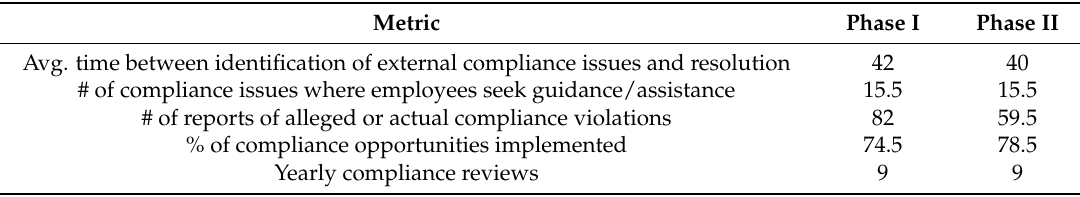
Table 8. Compliance metrics, comparison of phases. Inter